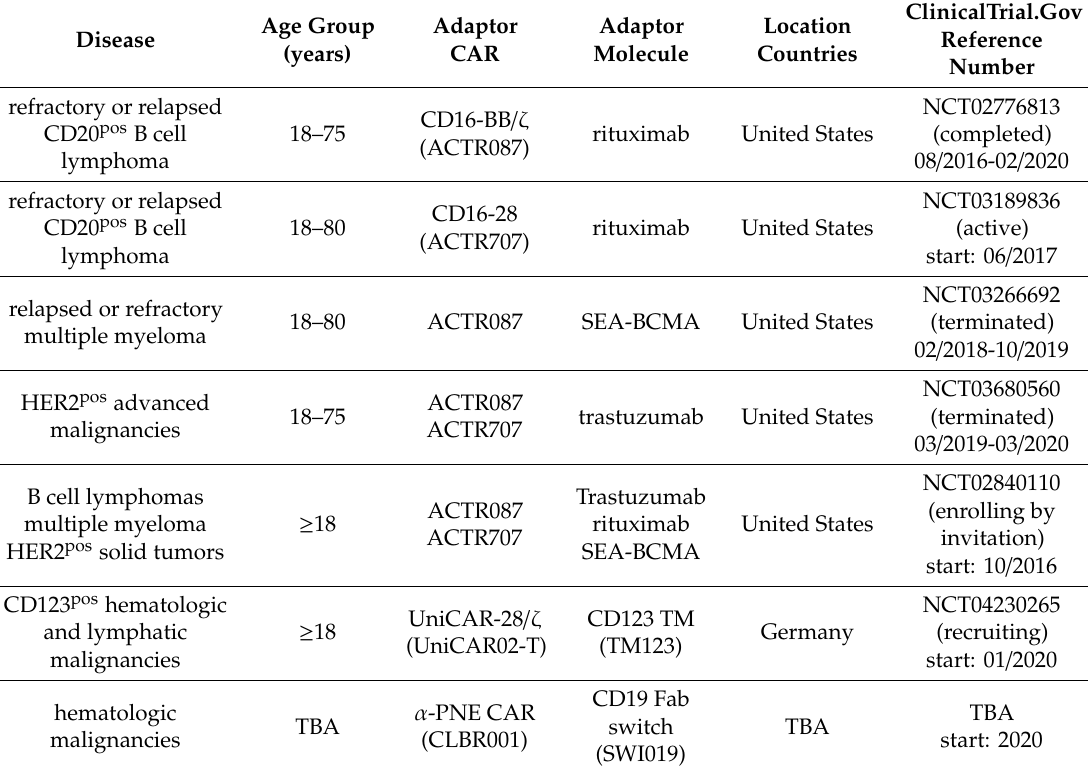
Table 1. Clinical trials of adaptor CAR T cells in the United States and Europe. ACTR: antibody-coupled T cell receptor; TBA: to be